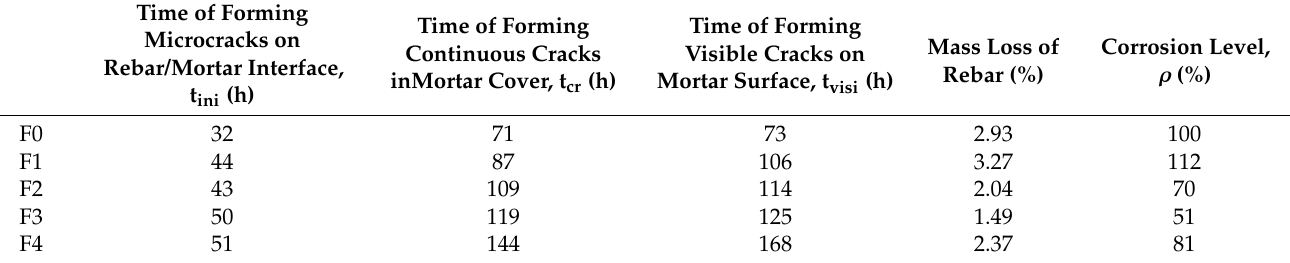
Table 5. Corrosion characteristics of reinforced mortar.